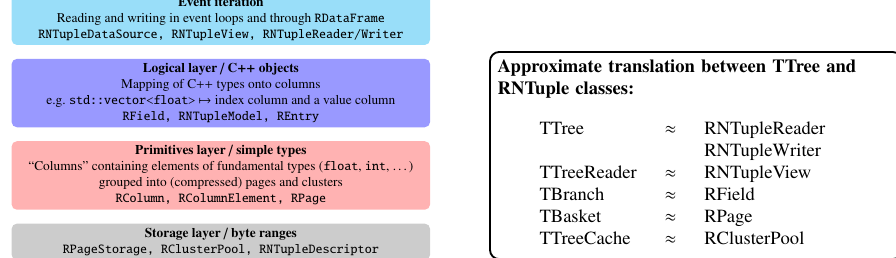
Figure 2. Layers and key class of RNTuple and their approximate counterparts in